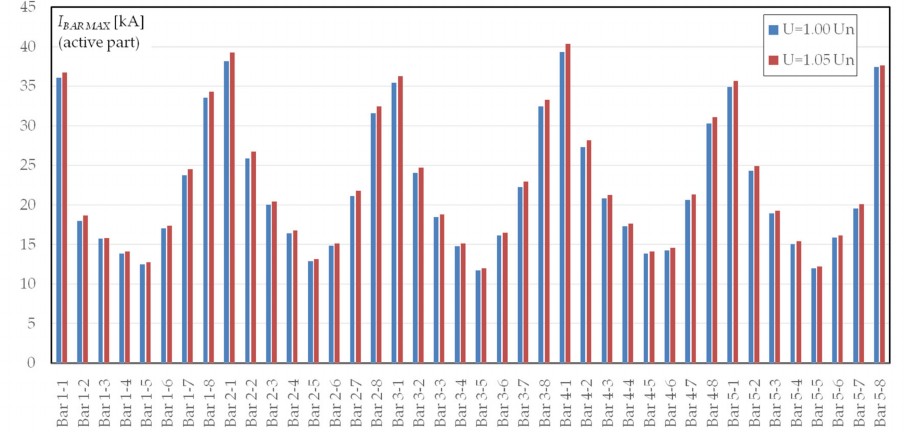
Figure 9. Distribution of maximum values of currents induced in the active part of the rotor bar at 180° of voltage phase shift.